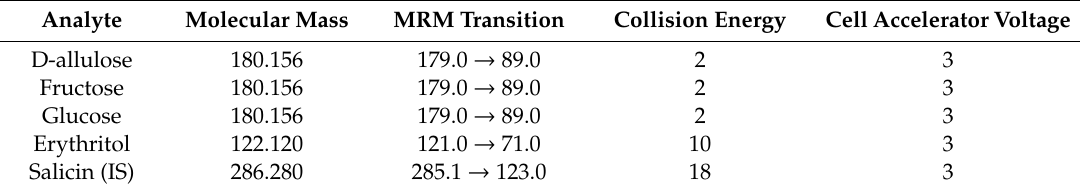
Table 3. Optimized electrospray ionization-mass spectrometry (ESI-MS) parameters including multiple reaction monitoring (MRM) conditions.